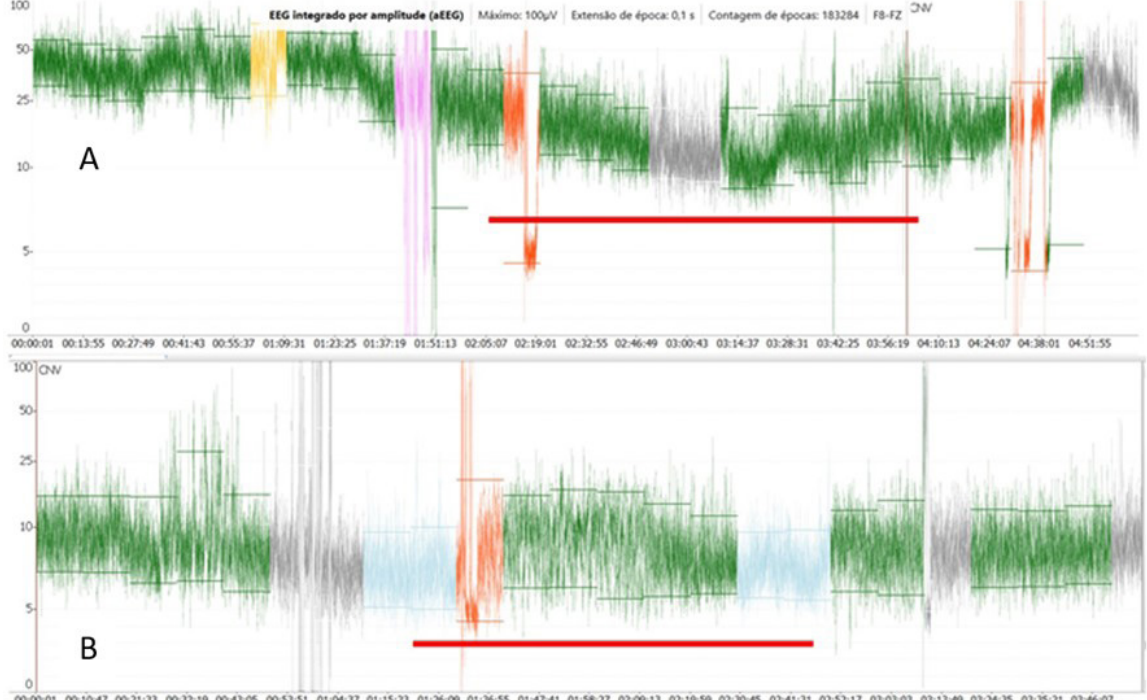
Fig. 4 - Two frontal channels aEEG complete recordings from two patients with general anesthesia maintained with sevoflurane, remifentanil, and dexmedetomidine: A) Five-months and 20-days of age patient undergoing atrioventricular canal defect repair; B) one-month and 25-days of age patient undergoing Tetralogy of Fallot repair. The amplitudes (maximum, minimum, and average) and the background patterns trends are appropriate for their ages. However, the upper trace have higher amplitudes and less variations that may reflect the cerebral maturation during the first year of life.